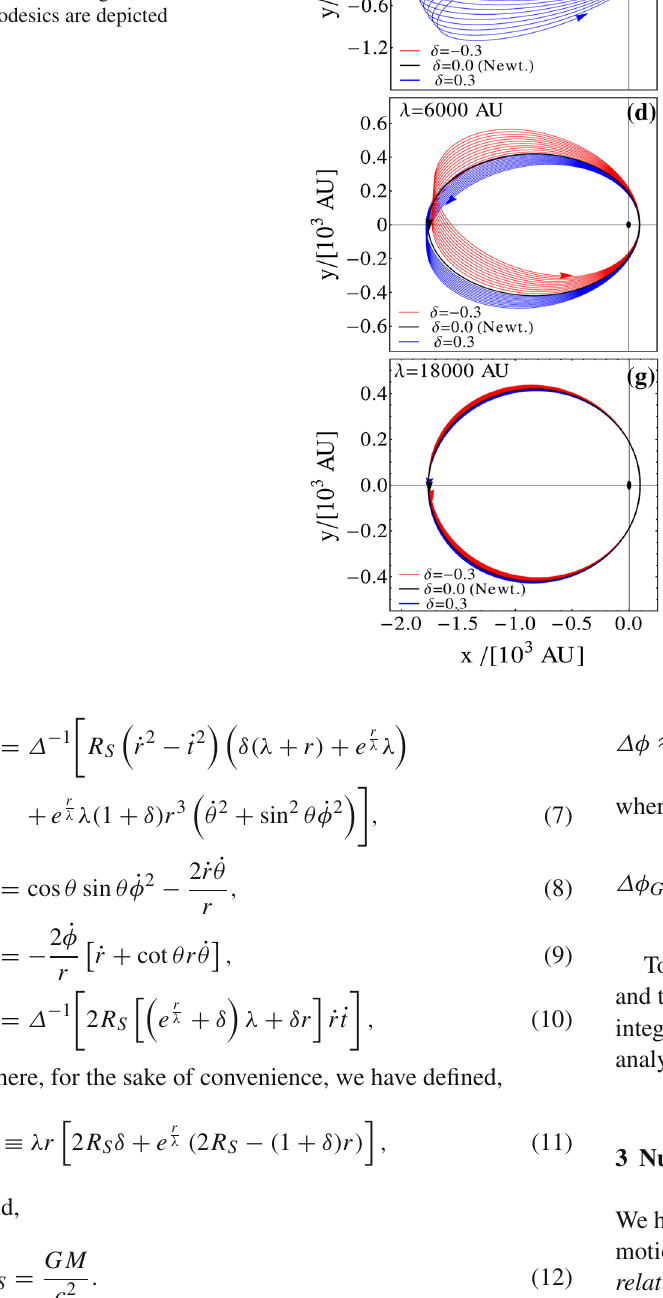
Fig. 1 Numerical integration of the equation of motion. Specifically, a , d , and g show the results of the semiclassical approach, while in the other panels the results of the numerical integration of the geodesics are